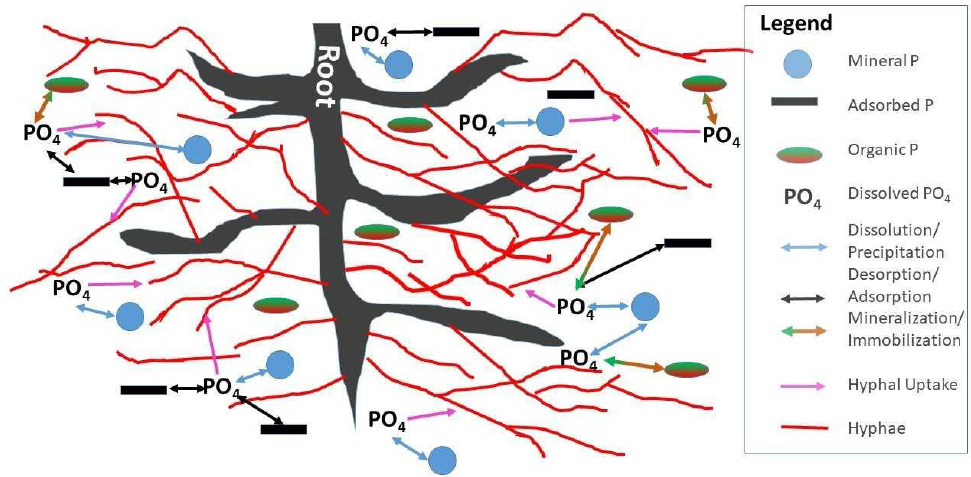
Figure 2. Interactions among spatially distributed organic, adsorbed, and particulate mineral phosphorus microsites, soil Scheme 4 and mycorrhizae hyphae.